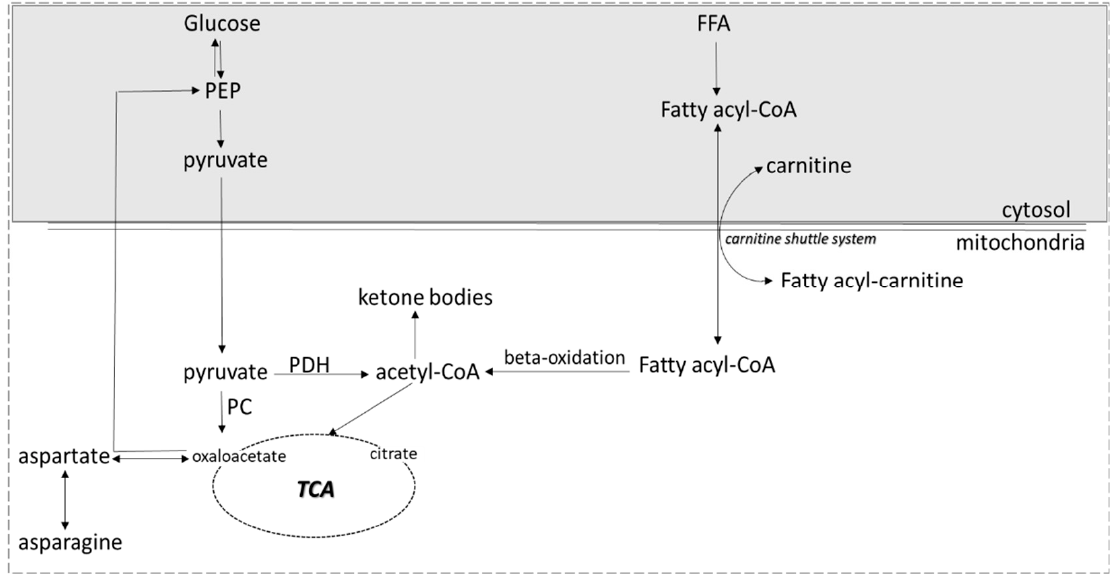
Figure 2. Affected metabolic pathways in GDM (pyruvate metabolism, beta-oxidation, ketone bodies metabolism).